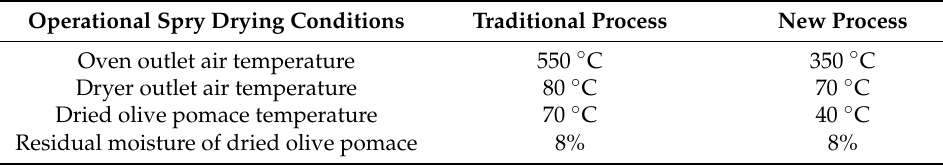
Table 2. Technical data concerning the drying